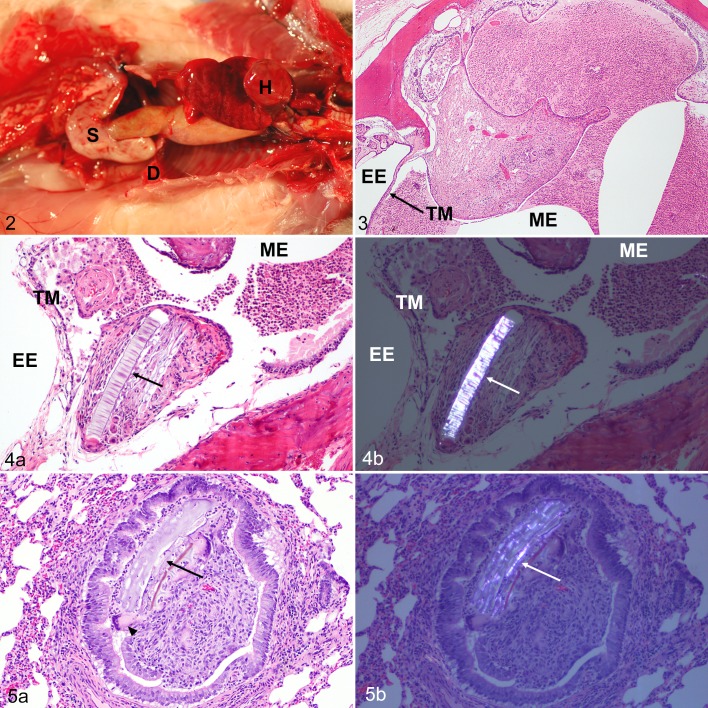
Megaesophagus and aspiration pneumonia, 34-week-old Rbm20–/– rat. The esophagus is markedly dilated; its closed
esophageal diameter was 17 mm. D, remnant of removed diaphragm; H, heart; S, stomach.
Figures 3–4. Chronic otitis media, 36-week-old Rbm20–/– rat with megaesophagus. Figure 3. The
middle ear (ME) cavity is filled by pyogranulomatous inflammation with thickening of the
tympanic membrane (TM). Hematoxylin and eosin (HE). Figure 4. The middle
ear contains viable and degenerate neutrophils admixed with macrophages, surrounding
intralesional foreign material (a) that is birefringent under polarized light (b,
arrow), indicating plant origin. HE. EE, external ear canal. Figure 5.
Chronic aspiration pneumonia, 41-week-old Rbm20–/– rat with megaesophagus. A bronchiole is filled with
viable and degenerate neutrophils admixed with macrophages, some multinucleated
(arrowhead), surrounding intralesional plant material (a) that refracts polarized light
(b, arrow). HE.